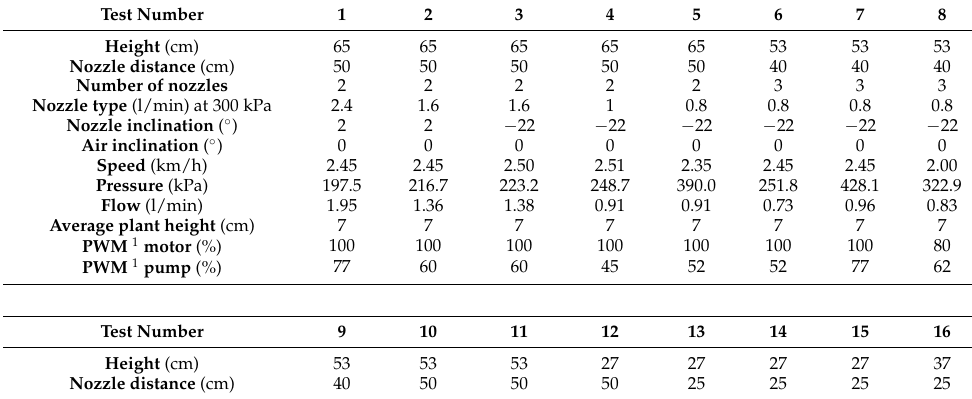
Table A2. Selected parameters of all 37